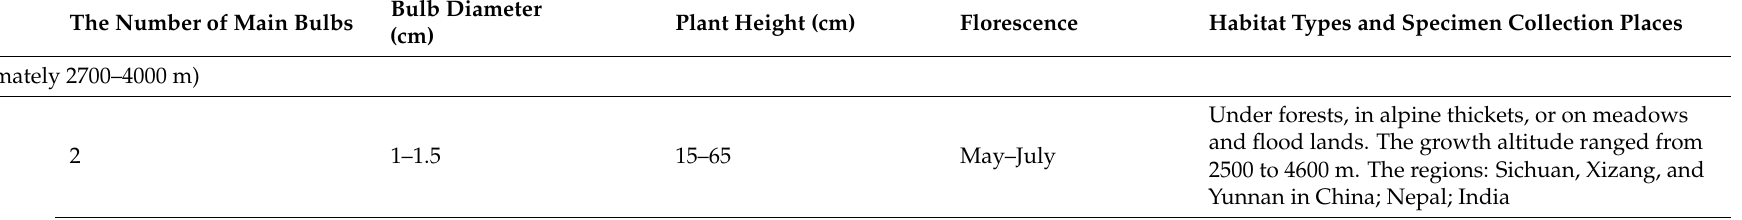
Table 1. The main morphological features and the types of alkaloids of medicinal Fritillaria